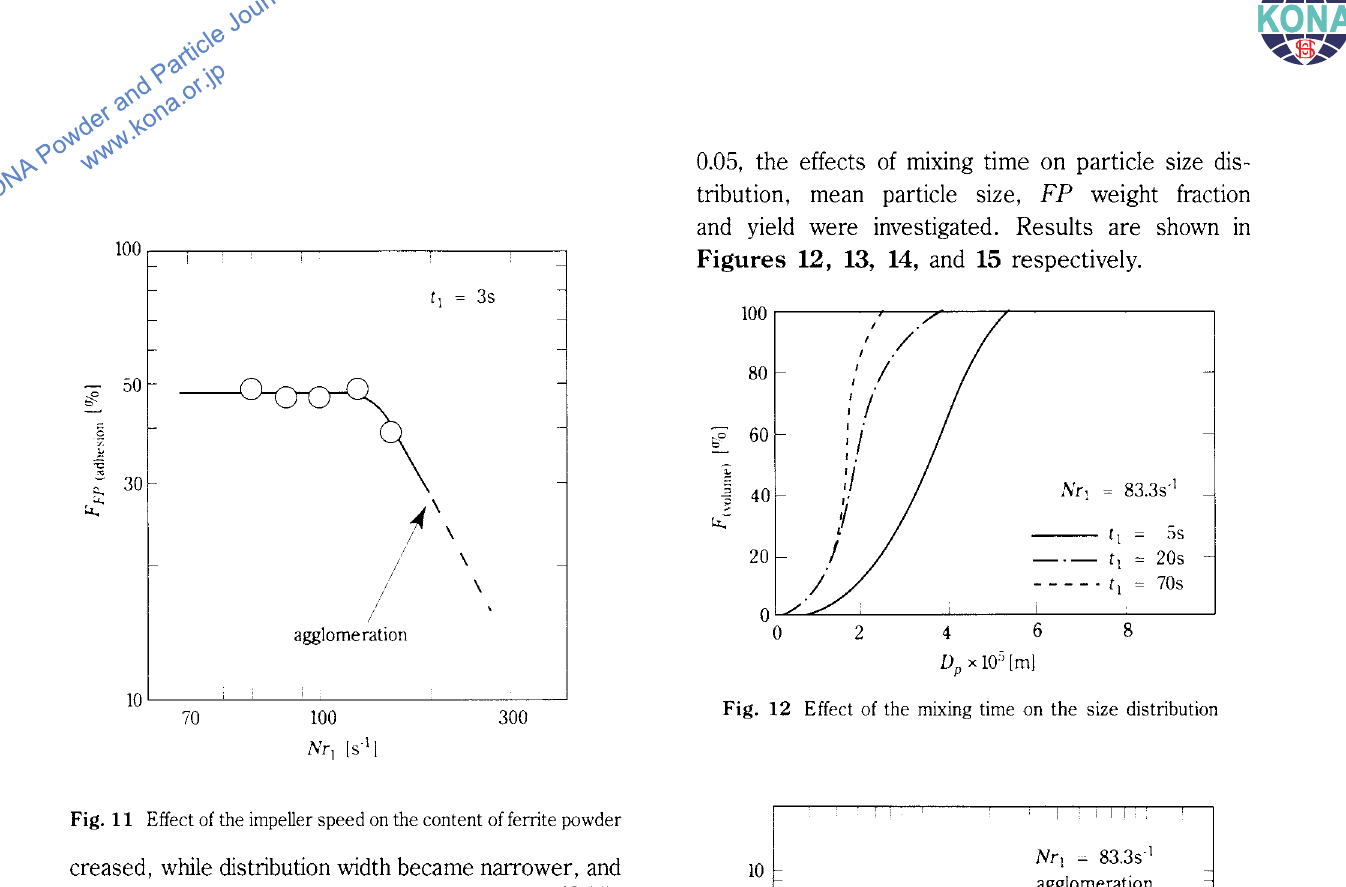
Fig. 11 Effect of the impeller speed on the content of ferrite powder creased, while distribution width became narrower, and liquid drop separation was promoted dominantly12-14).